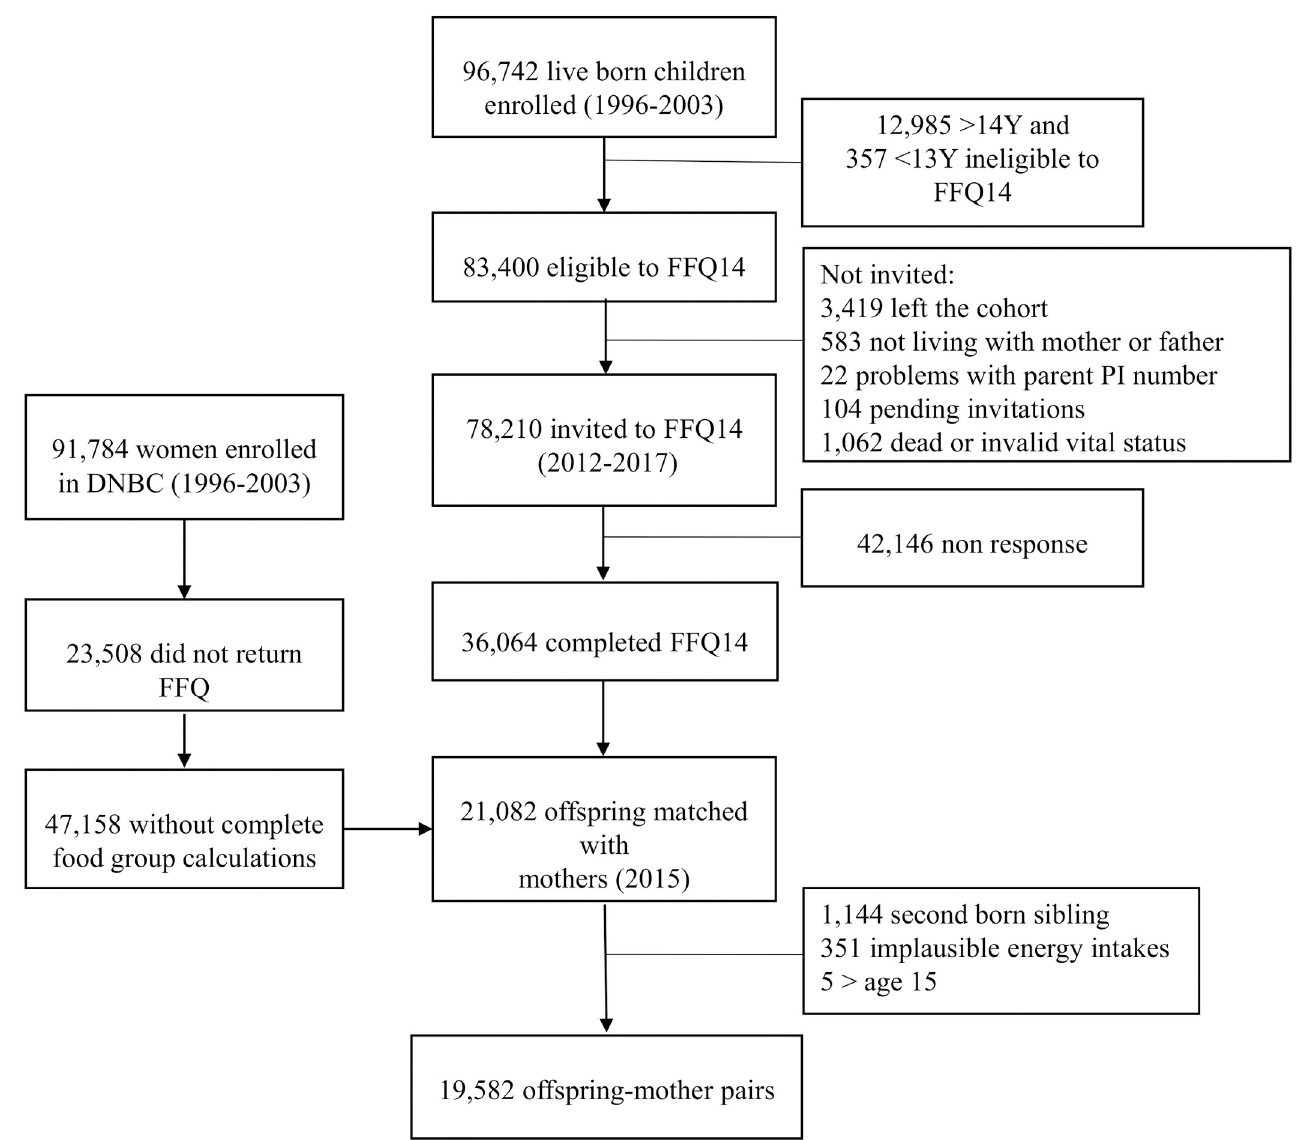
Fig 1. Flowchart. DNBC, Danish National Birth Cohort; FFQ, food frequency questionnaire.